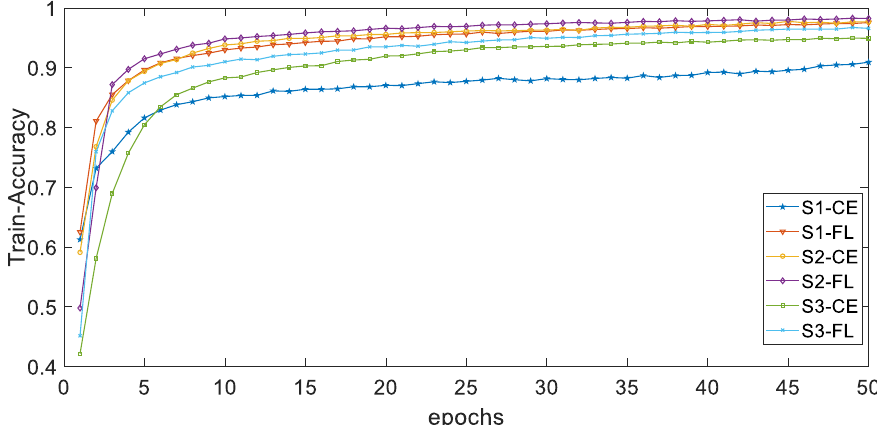
Figure 12. The curves of the accuracy of DH training sets with epochs.